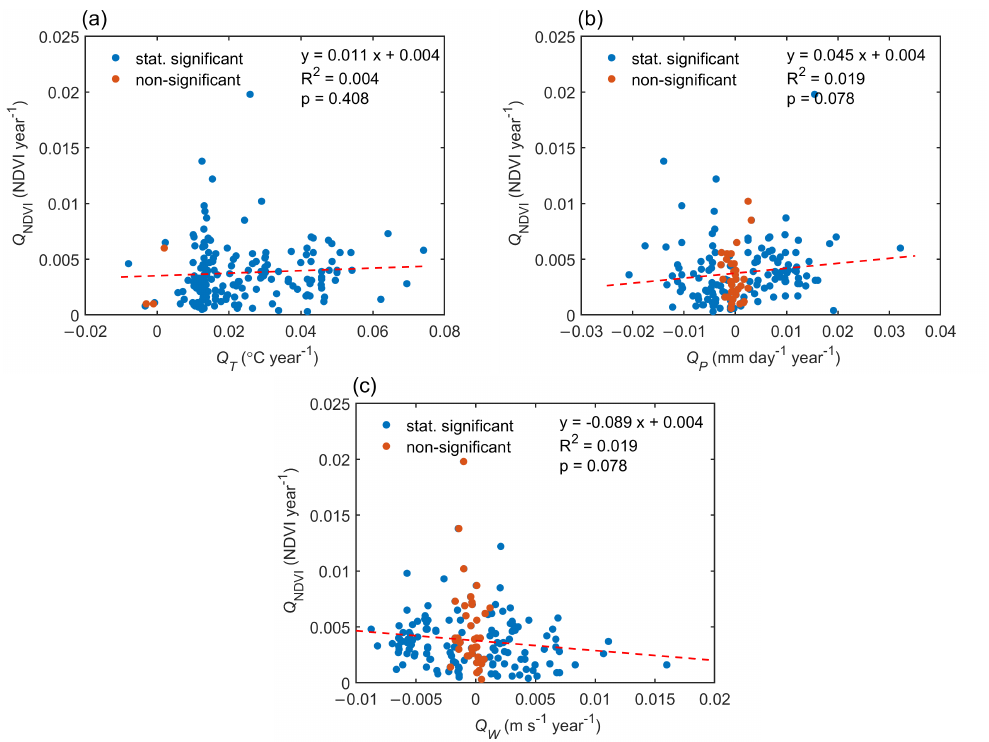
Figure 10. Sen’s slope Q NDVI versus the Sen’s slope in ( a ) temperature Q T , ( b ) precipitation Q P and ( c ) wind speed Q W for the greening dune sites. Blue and brownish dots indicate whether Sen’s slope in the climate variables is statistically significant, see also Table 3. The red line in each panel is the best-fit linear line, with details given in the upper right. None of these lines is statistically significant at α =